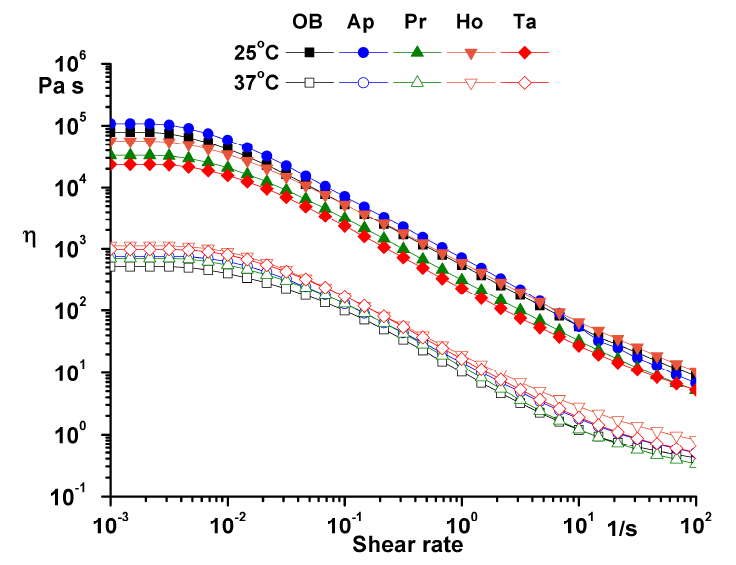
Figure 6. Flow curves for analyzed ointments. OB—ointment base, Ap—ointment base + apilarnil, Pr—ointment base + propolis, Ho—ointment base + honey, Ta—ointment base + mixture of bee